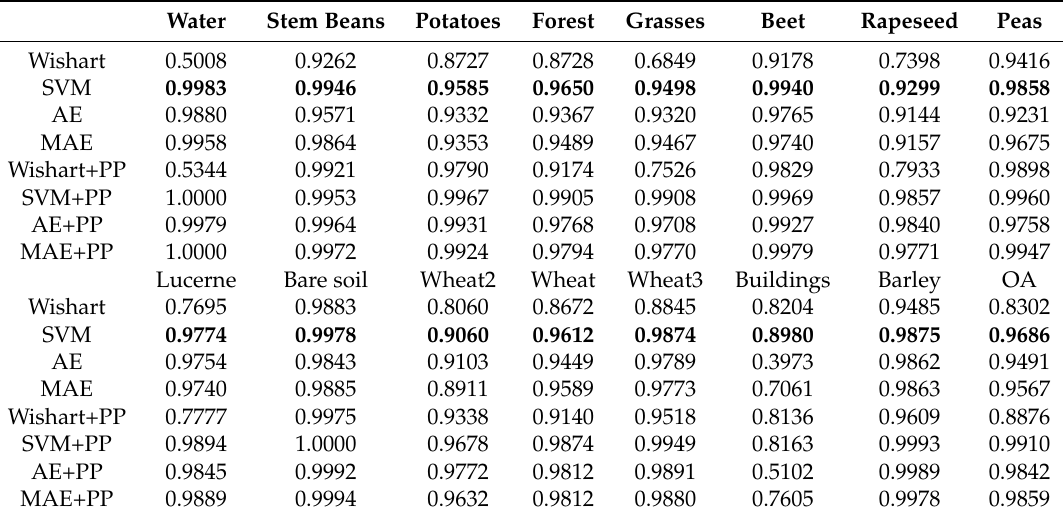
Table 9. The correct rate of each category and overall accuracy for the four comparison methods and those of the corresponding PP steps for FLEVOLAND image. Water Stem Beans Potatoes Forest Grasses Beet Rapeseed